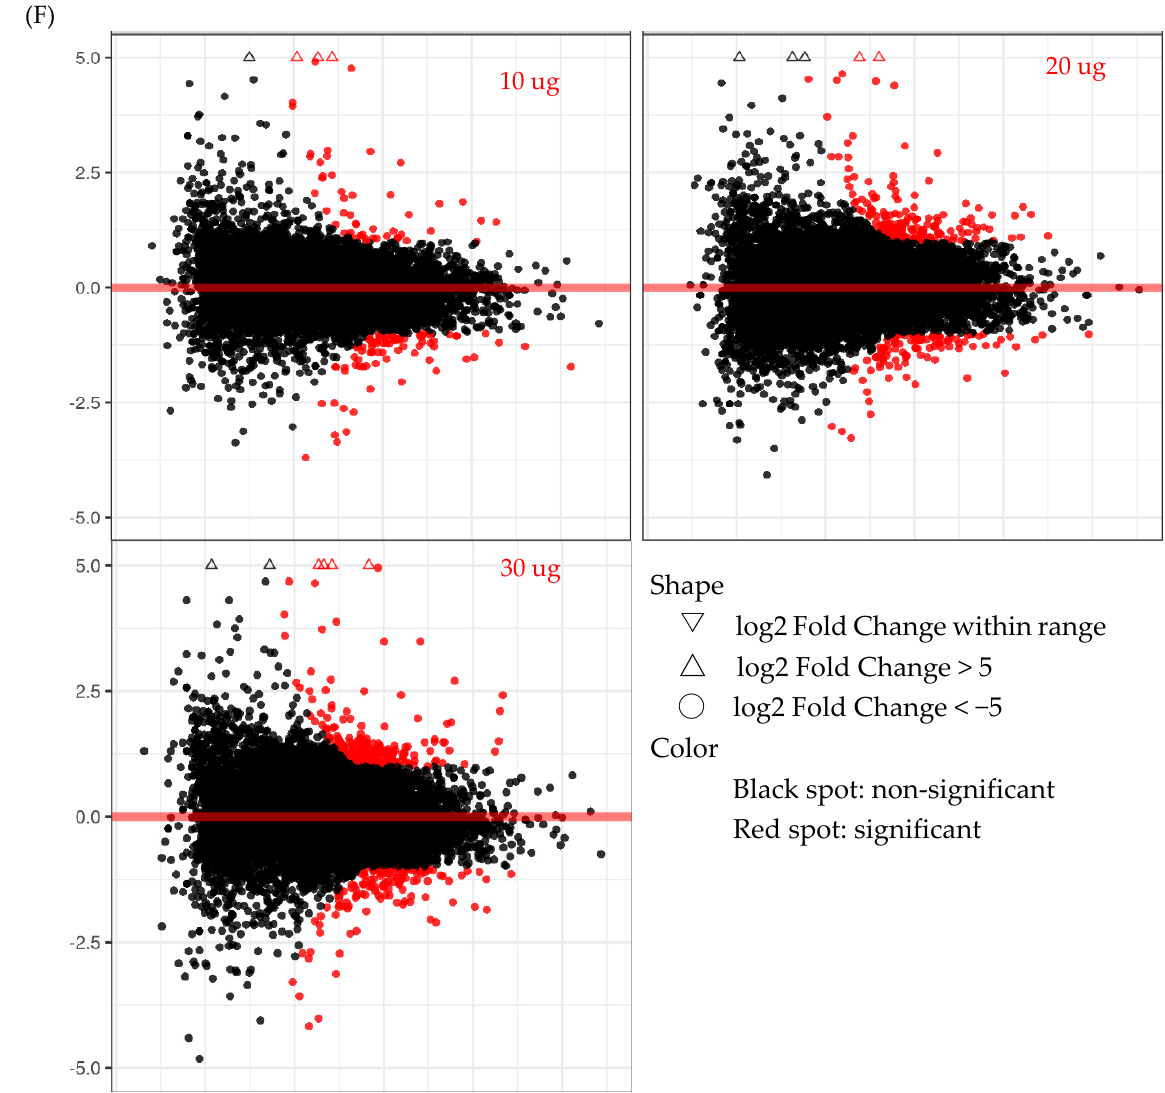
Figure 4. RNA sequencing (transcriptome) analysis: ( A ) Acetyl-xylogalactan may have affected the counts of the apoptosis gene, as 10 counts were presented in the KEGG analysis. ( B ) Acetyl-xylogalactan may have regulated the relative cell phenomenon; ( C ) log two-fold change of the acetyl-xylogalactan various concentration treatment. Totals of 10 μ g ( D ), 20 μ g ( E ), 30 μ g ( F ) Volcano map of the treatments with various concentrations of acetyl-xylogalactan treatment. (Treatment was presented; 10 μ g means 10 μ g of acetyl-xylogalactan/mL (culture medium); 20 μ g means 20 μ g of acetyl-xylogalactan/mL (culture medium); 30 μ g means 30 μ g of acetyl-xylogalactan/mL (culture medium)).